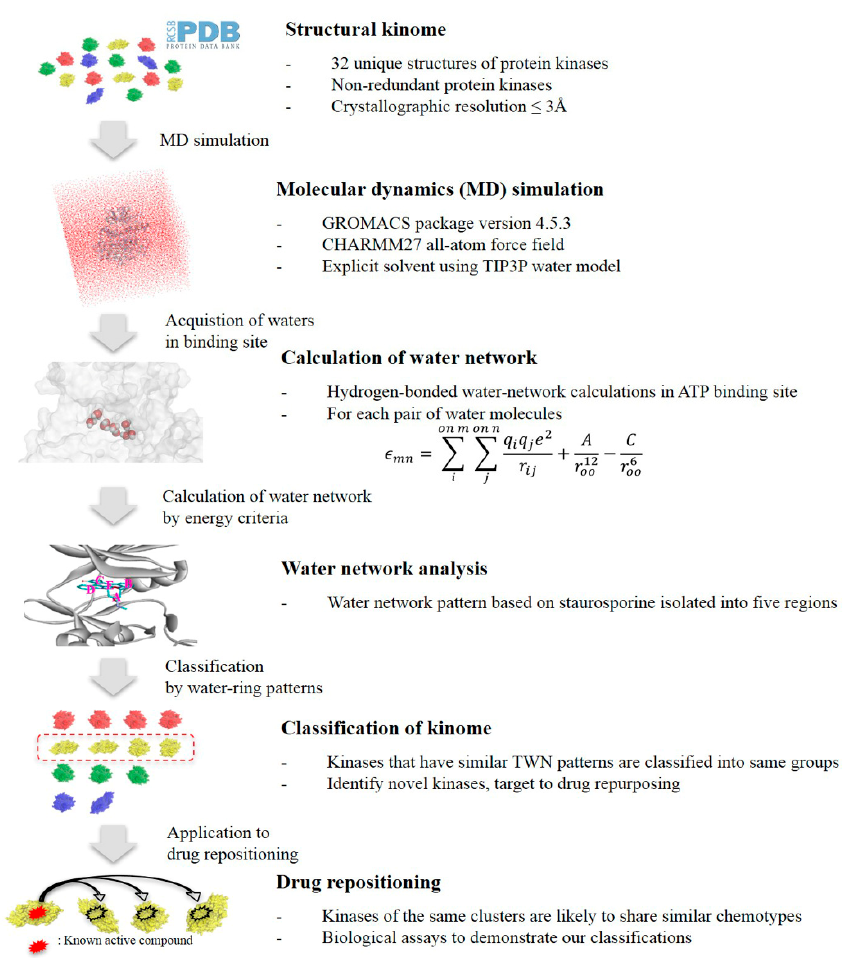
E, as shown in Figure 3. TWN analysis revealed a high percentage of water molecules in the D-site of